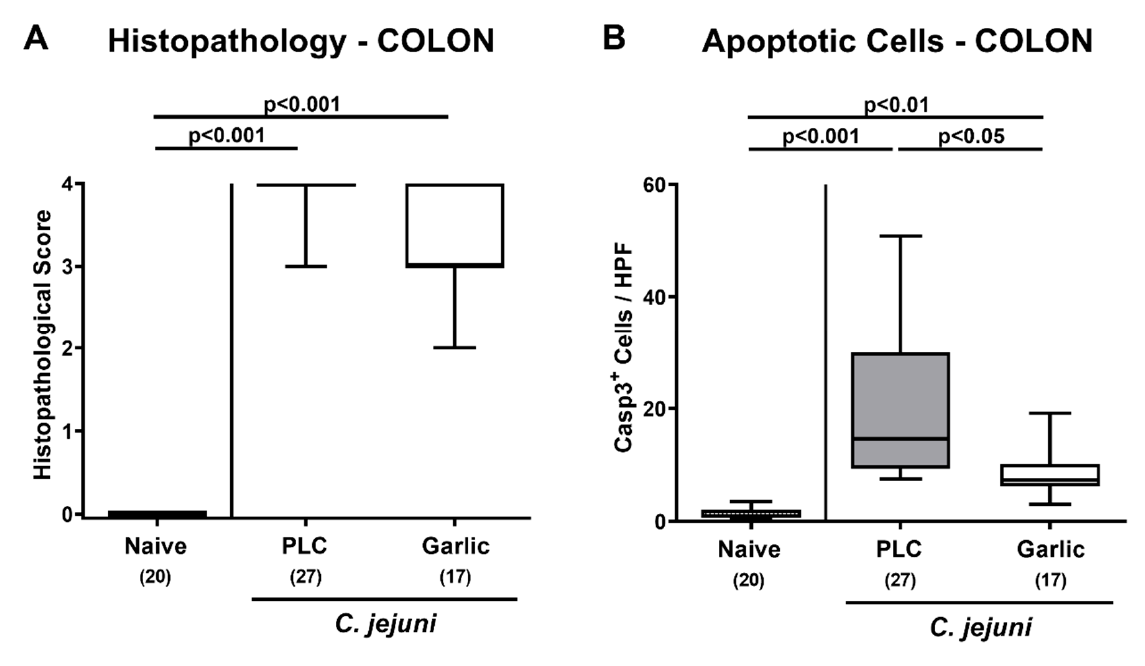
Figure 3. Microscopic inflammatory sequelae upon garlic essential oil treatment of C. jejuni infected IL-10 -/- mice. Secondary abiotic IL-10 -/- mice were orally challenged with C. jejuni strain 81-176 on days 0 and 1 followed by treatment with either garlic essential oil (white boxes) or placebo (PLC, gray boxes) via the drinking water starting on day 2 post-infection. On day 6 post-infection, ( A ) microscopic inflammatory changes were assessed in colonic ex vivo biopsies applying histopathological scores. Furthermore, ( B ) the mean numbers of apoptotic colonic epithelial cells out of six high power fields (HPF, 400 × magnification) were enumerated microscopically in paraffin sections that had been stained with an antibody against cleaved caspase3 (Casp3 + ). Naive mice (hatched boxes) served as non-infected and untreated cohort. Box plots (indicating the 25th and the 75th percentiles), whiskers (indicating maximum and minimum values), medians (black bar inside box), significance levels ( p values) determined by the Kruskal-Wallis test and Dunn’s post-correction and the total number of mice (in parentheses) are shown (pooled data from four independent experiments).